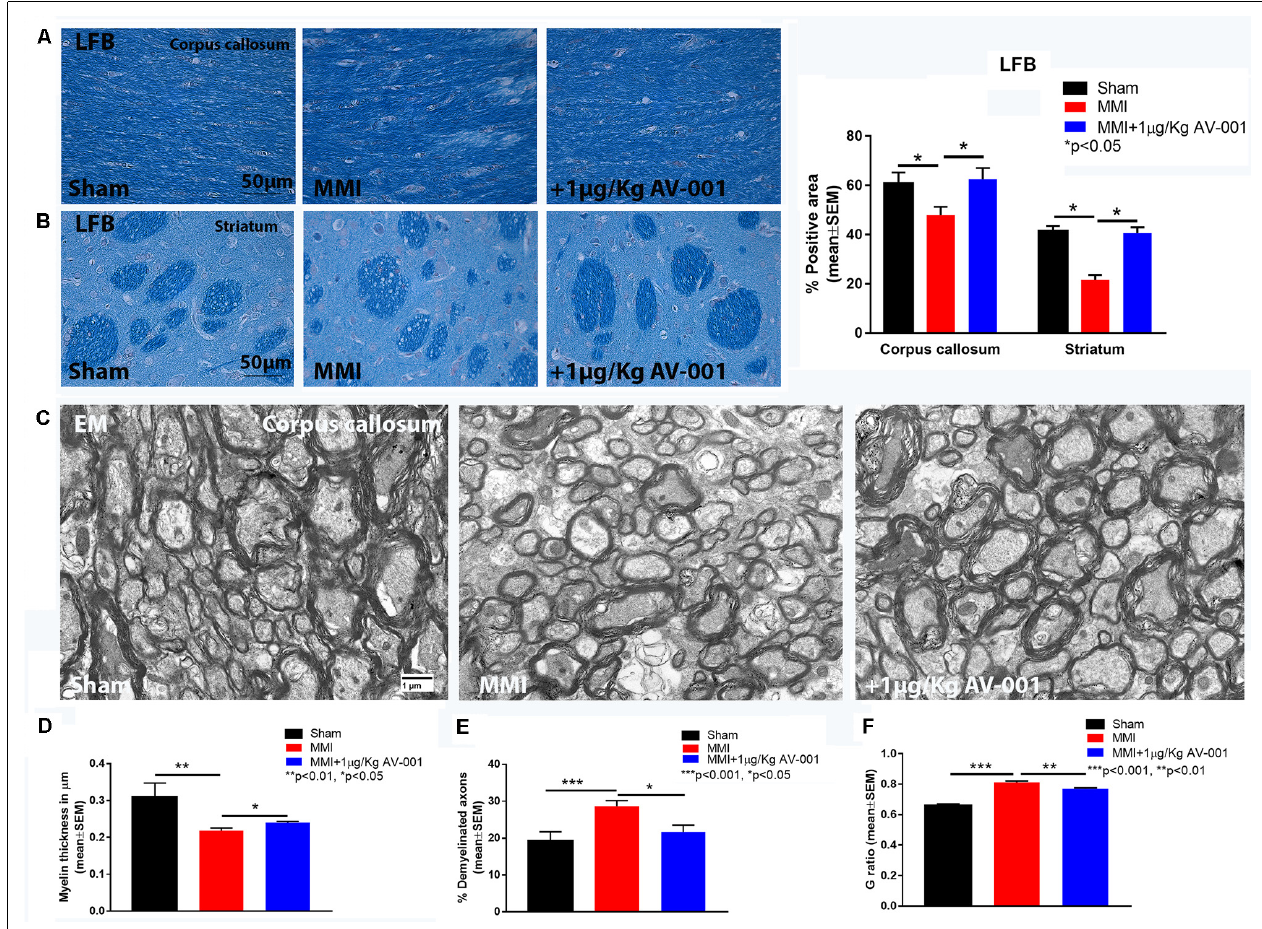
FIGURE 5 | AV-001 treatment significantly improves myelin density in the brain of middle-aged rats subjected to MMI. (A,B) Representative images and quantification data of luxol fast blue (LFB) staining in the Corpus callosum and Striatum. MMI significantly reduces myelin density in the Corpus callosum and white matter bundles of the striatum compared to Sham control rats. Treatment with 1 µ g/Kg AV-001 significantly increases myelin density in the Corpus callosum and Striatum compared to MMI rats. (C–F) Representative images and quantification data of electron microscopy in the corpus callosum. MMI significantly reduces myelin thickness, increases the number of demyelinated axons and increases G-ratio compared to Sham control rats. 1 µ g/Kg AV-001 treatment significantly increases myelin thickness, reduces the number of demyelinated axons and reduces G-ratio compared to the MMI control